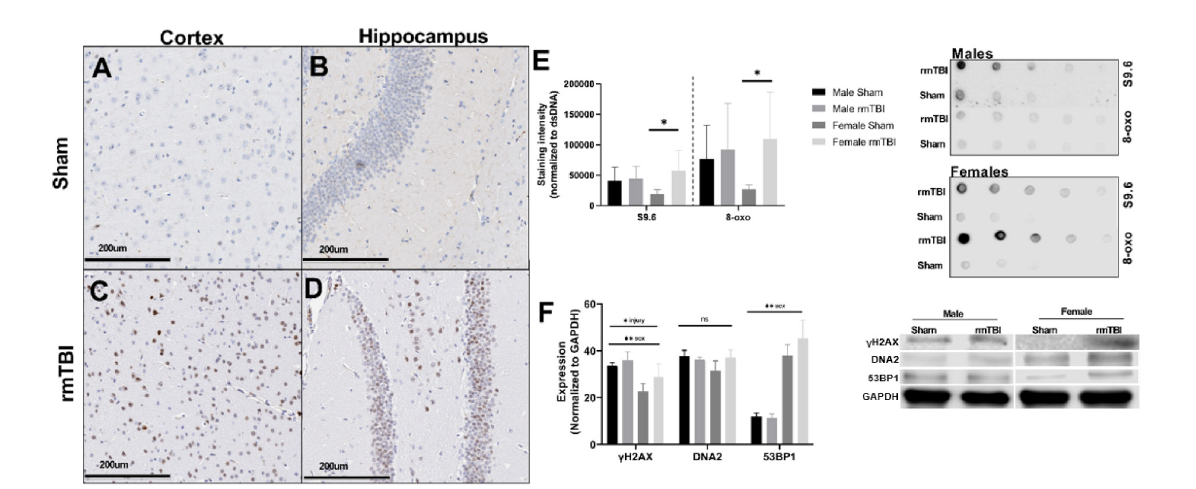
FIGURE3 Deoxyribonucleic acid (DNA) damage accumulates near the region of impact 1 week after rmTBI. DNA damage is evident 1 week post-injuries. Immunohistochemistry for yH2AX in female mice reveals DNA damage in the form of DSBs accumulates after rmTBI in both the cortex at the impact region ( A,C , scale bar represents 200 µ m) and underlying hippocampal dentate gyrus ( B,D , scale bar represents 200 µ m), with minimal staining in shams. Staining of dsDNA with S9.6 to assess levels of R-Loop structures revealed a significant main effect of injury ( p = 0.05, two-way ANOVA), and post-hoc testing indicates that this increased expression is only significant in the female rmTBI mice compared to their sham counterparts ( p = 0.04, Bonferroni). Staining of dsDNA for 8-oxo to assess oxidative base damage shows a similar trend, with a main effect of injury nearing significance ( p = 0.08, two-way ANOVA) and post-hoc testing revealing the increased expression to be significant only in female mice ( p = 0.04, Bonferroni). Representative images of the dot blot are shown to the right of the quantification plot (E) . Using Western Blotting, protein levels of yH2AX were found to be significantly increased in rmTBI mice compared to controls (F) ( p = 0.05, main effect of injury, two-way ANOVA), with a significant effect of sex ( p = 0.0004, main effect of sex, two-way ANOVA) and no significant interaction. DNA2 trended toward increased expression in female rmTBI mice compared to shams, but did not reach statistical significance (F) . 53BP1 was found to have a significant main effect of sex ( p < 0.0001, two-way ANOVA) but no significant main effect of injury, however, it was trending toward increased expression in female rmTBI mice compared to shams. Representative blots are shown to the right of the plot (F) . Error bars represent standard deviation and there are n = 4 per group. Indication of statistical significance is as follows: ∗ p <